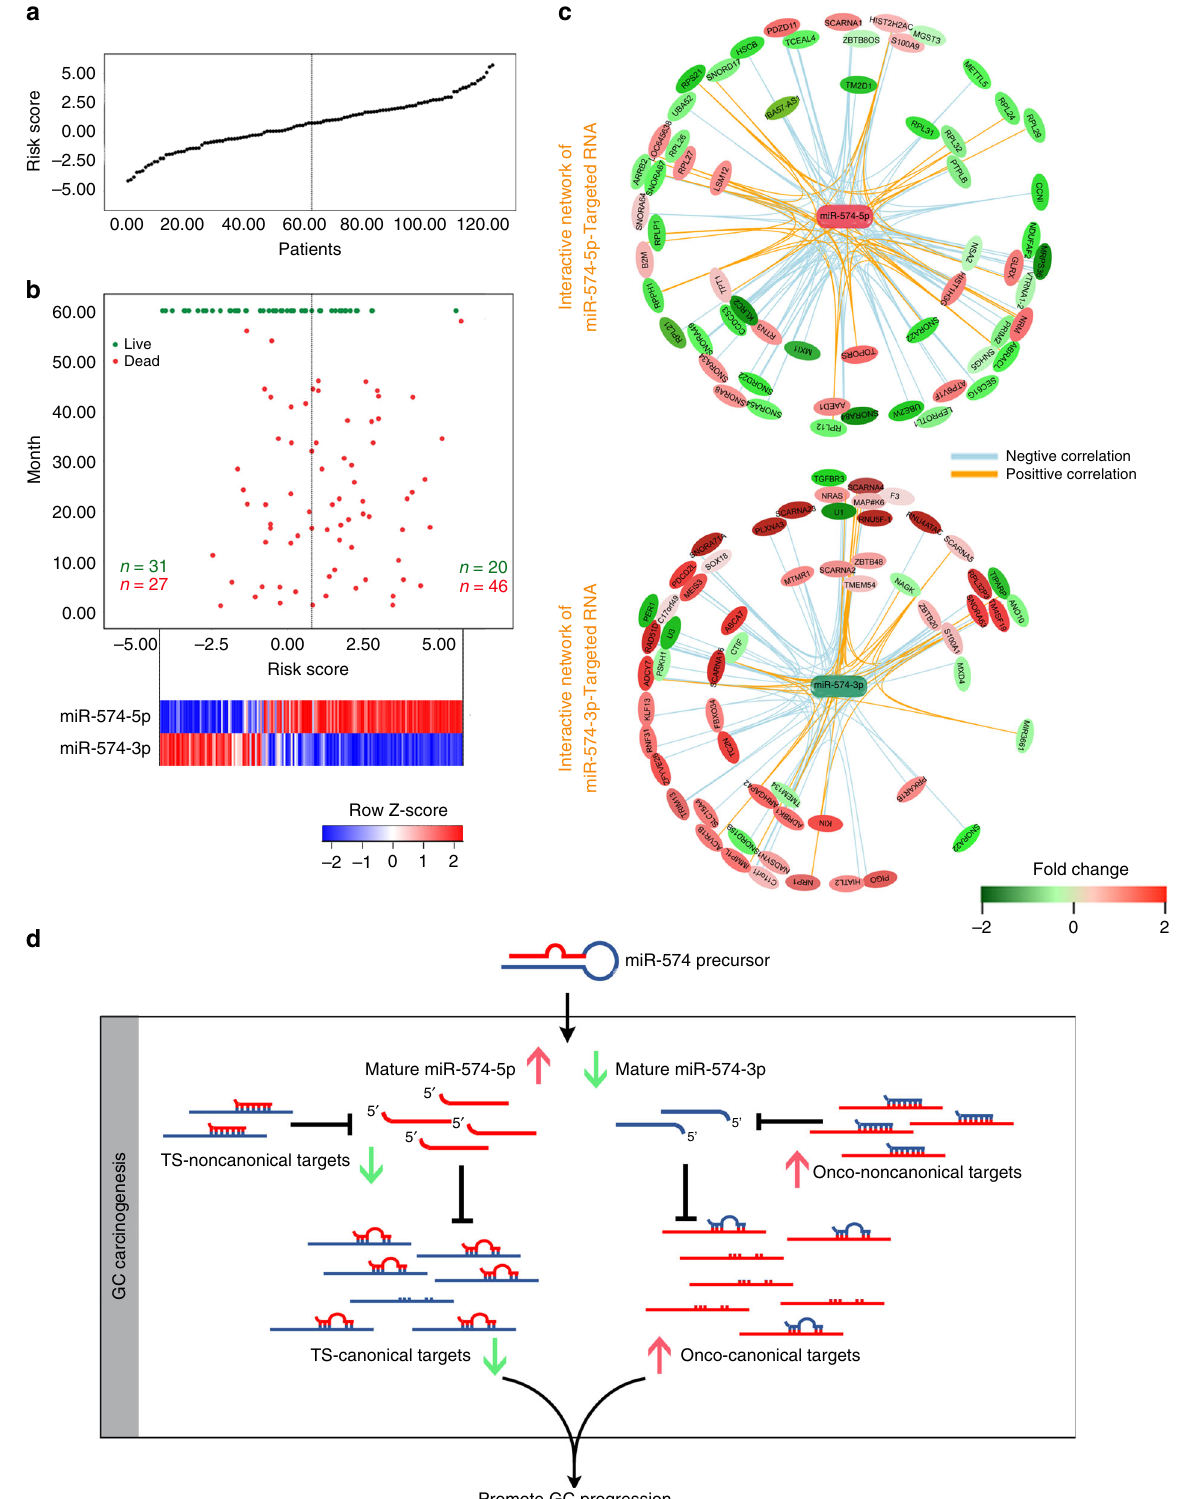
Fig. 7 Arm-imbalance of miR-574 was correlated with poor prognosis of GC patients. a Risk-score distribution of the 124 GC patients. b Survival status and time of patients with according risk scores, and the miR-574-5p/3p expression pro fi les of patients with GC. c Network of miR-574-5p/-3p and their potential targets during gastric carcinogenesis. d Working model of arm-imbalance of miR-574 in promoting GC progression. Ts: tumor suppressor; Onco: